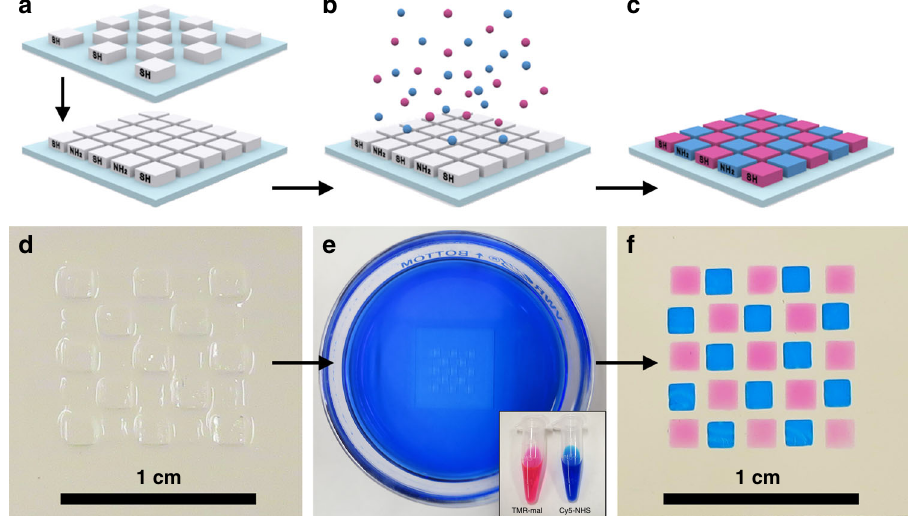
Fig. 4 Positioning of functionalities within printed structures. Illustrations ( a – c ) and photographs ( d – f ) of the spatially controlled deposition of silica cages with different functional groups and the selective binding of organic dyes. Two independent layers of cages functionalized with either thiol or amine groups are printed successively in a shifted checkerboard pattern ( a , d ). The pattern is then exposed to a mixture of TMR-mal and Cy5-NHS dyes ( b , e ), which bind selectively to the thiol and amine functionalized tiles, respectively ( c , f ). Between each step, the pattern was washed with